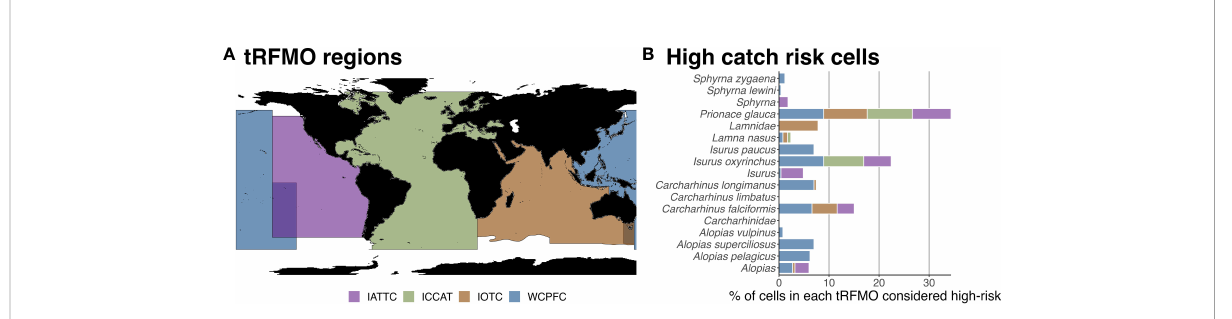
FIGURE 4 Distribution of high-risk cells across tRFMOs. The percentage of cells within a particular tRFMO (A) that are considered high-risk for shark species (B) . High-risk cells are areas in which the mean annual predicted catch of a species in a tRFMO is greater than or equal to the 90% quantile. Quantiles were calculated using non-zero mean annual predicted catch